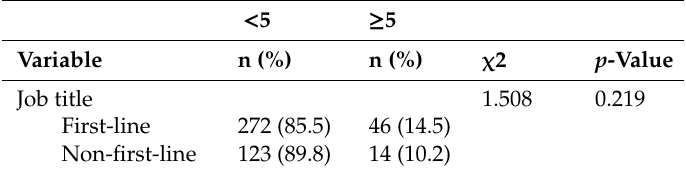
Table 6. Univariate analysis of working style and osteoporosis risk (n = 455). < 5 ≥